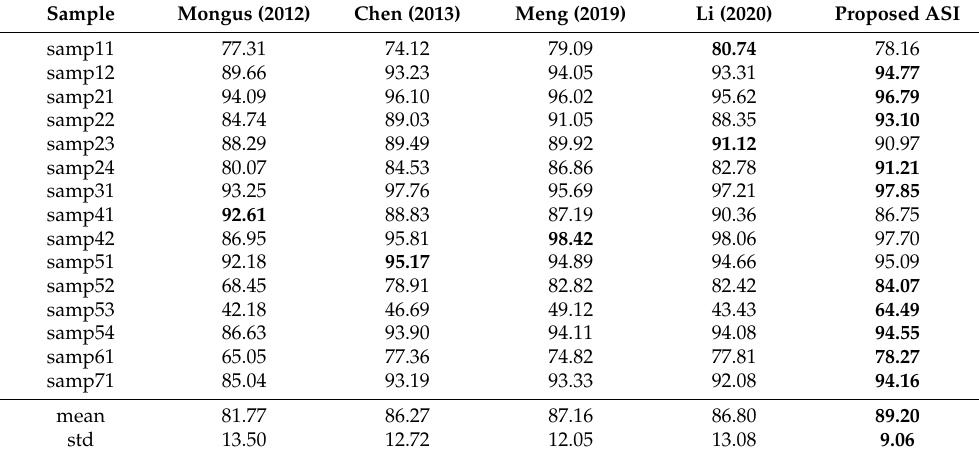
Table 6. Comparison between the kappa coefficients (%) of the proposed method and other interpolation-based methods. (The best results across all the methods at each sample are high- lighted in bold.)